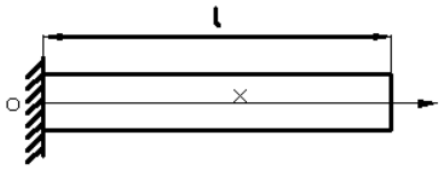
Figure 3. Schematic diagram of the simplified structure of the cantilever beam.